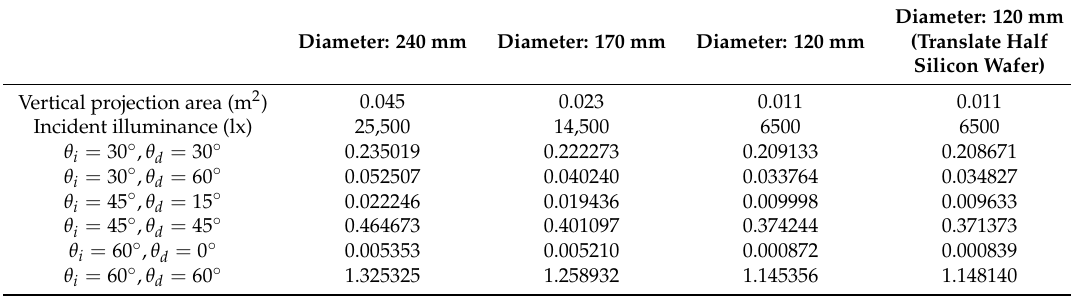
Table 3. The BRDF calculating data of the three conditions of spot